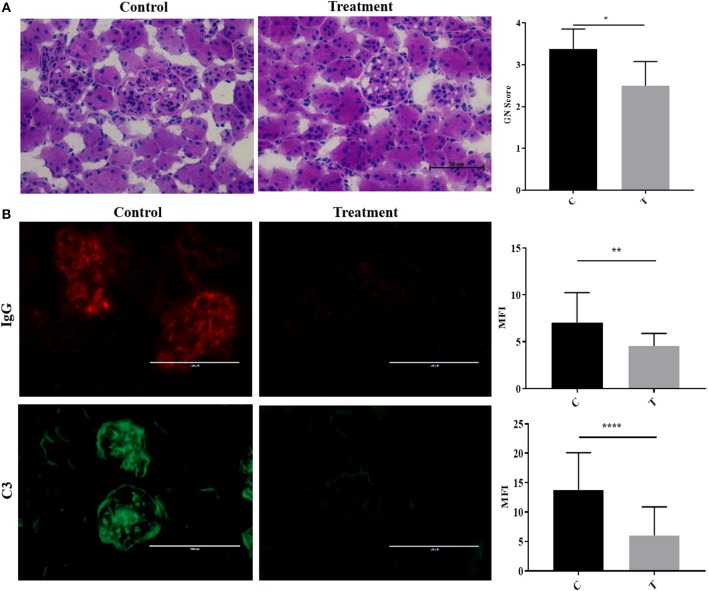
Inhibition of histone deacetylase HDAC6 reduced Ig and C deposition in NZB/W lupus nephritis. (A) Representative Hematoxylin and Eosin (H&E) staining image of kidney glomerular region along with pathology score which reflects the severity of membranoproliferative changes and distribution. (B) Representative immunohistological staining of kidney section for IgG and C3. Graphic analysis of mean fluorescent intensity (MFI) of IgG and C3 is also provided. Data are shown as mean ± standard error of the mean (s.e.m) n = 4 mice for each group; T-test; *P < 0.05, **P < 0.01, ****P < 0.0001.